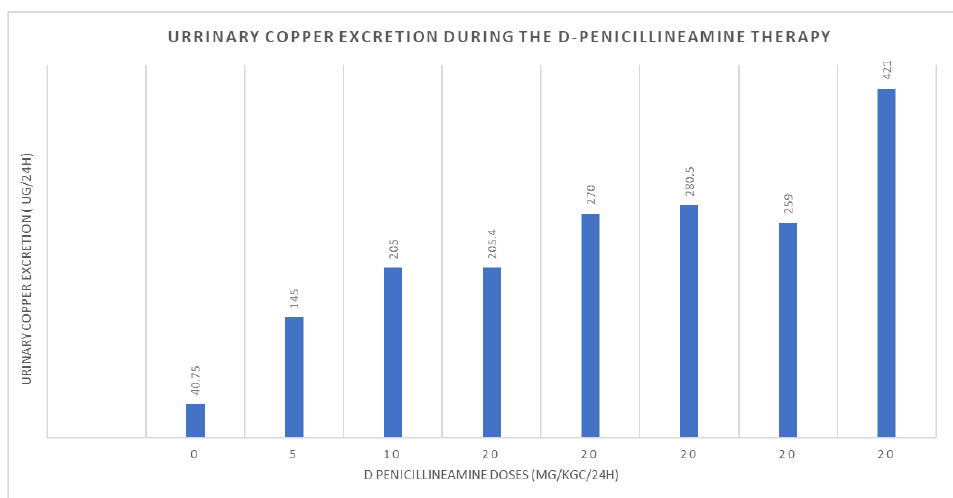
Figure 4. Urinary excretion of copper during the administration of copper chelators therapy.